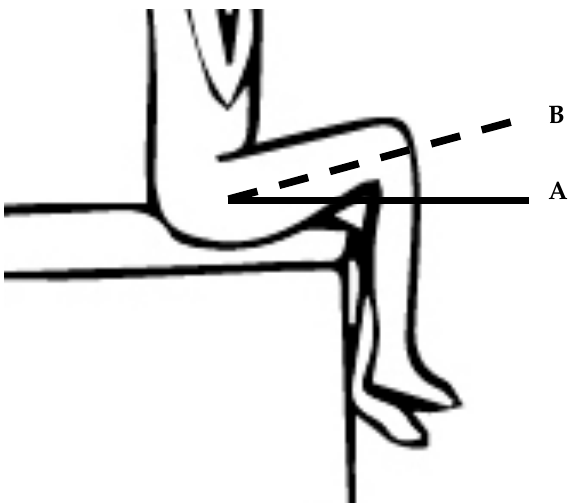
Figure 1. Seated hip flexion control test (end position): Line A illustrates the start position (90° hip and knee flexion) and Line B illustrates the end position (110° hip flexion).